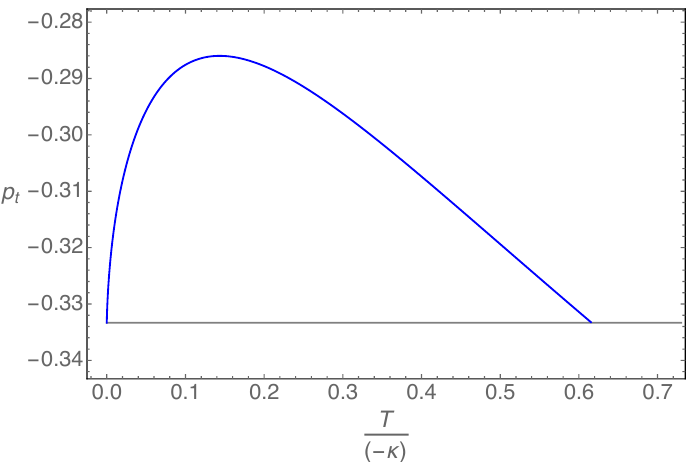
Figure 4 . The Kasner exponent p t as a function of T/ ( − κ ) for λ 3 = 0 , λ 4 = 1 / 10 . The grey line is p t of Schwarzschild singularity which is − 1 / 3 . The blue line is for p t of the hairy black hole solution. When T/ ( − κ ) goes to zero, p t goes to − 1 / 3